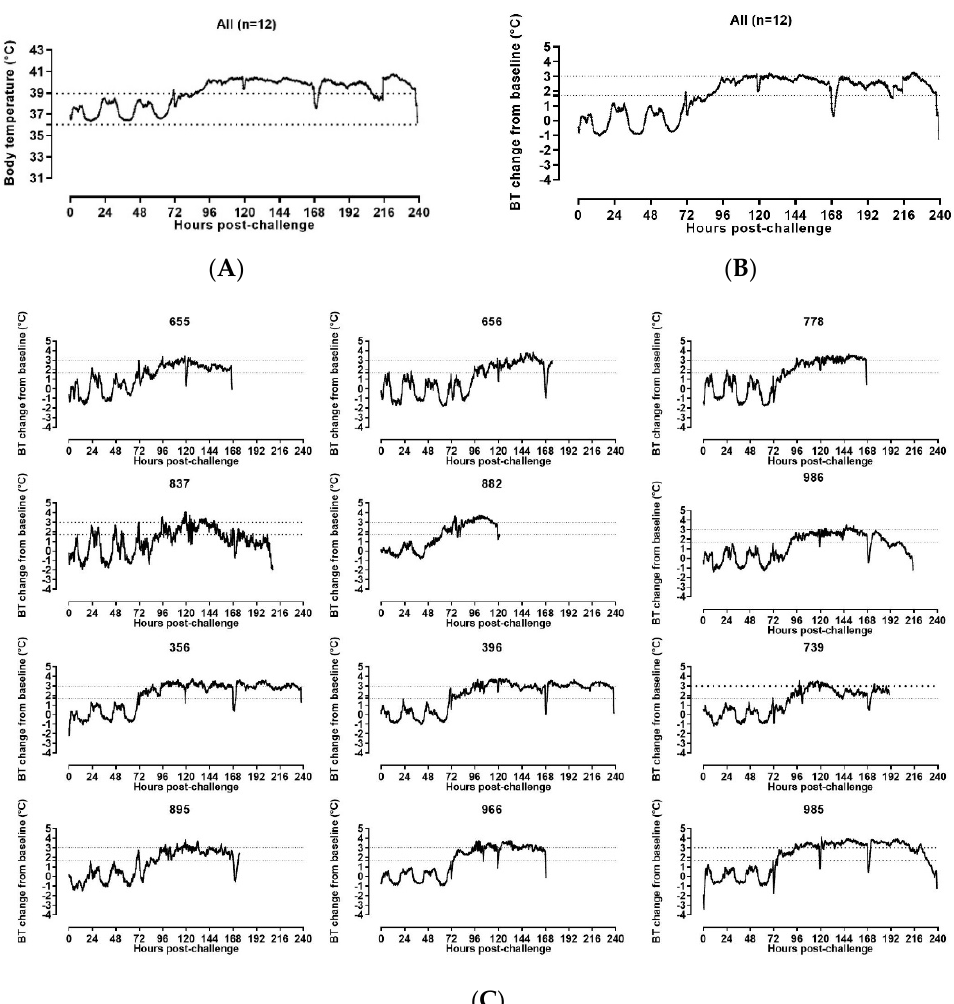
Figure 5. Star Oddi-based body temperature changes in SUDV-challenged animals. ( A ) Group mean StarOddi telemetry-based Body Temperature (BT) versus time. The straight dashed lines indicate the baseline minimum and maximum BT values. ( B ) Group mean StarOddi telemetry-based BT change from baseline versus time. ( C ) Star Oddi telemetry-based BT change from baseline in individual SUDV challenged animals versus time. ( B , C ): The straight dashed lines indicate the BT change from baseline corresponding to fever ( ≥ 1.7 ◦ C) and hyperpyrexia ( ≥ 3 ◦